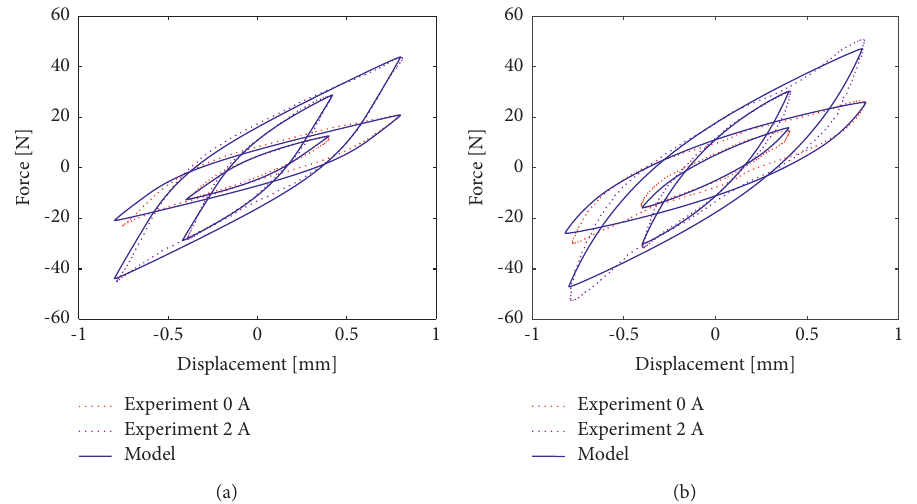
Figure 4: Force-displacement response under two displacement amplitude values ( x A (0mT) and I � 2 A (218 mT)): (a) f � 1 Hz and (b) f � 15 Hz.